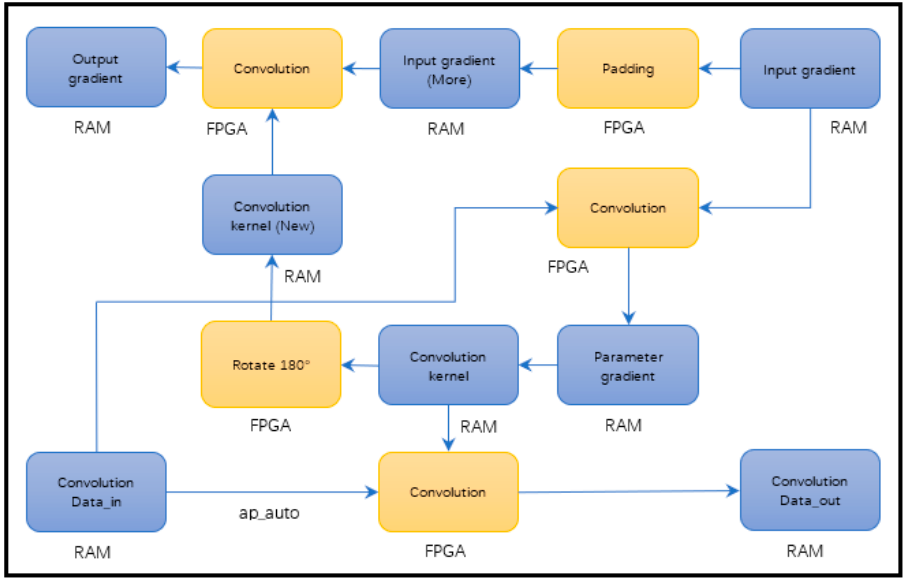
Figure 7. Forward propagation and backpropagation of the convolution layer.